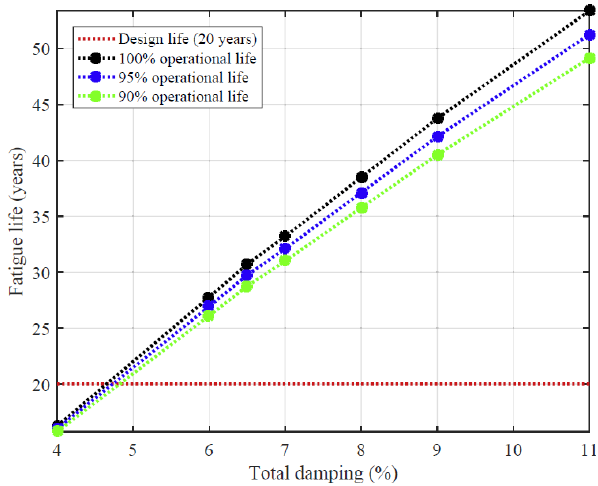
Figure 1. Comparison of the effect of the damping on OWT fatigue lifetime (Rezaei et al.,